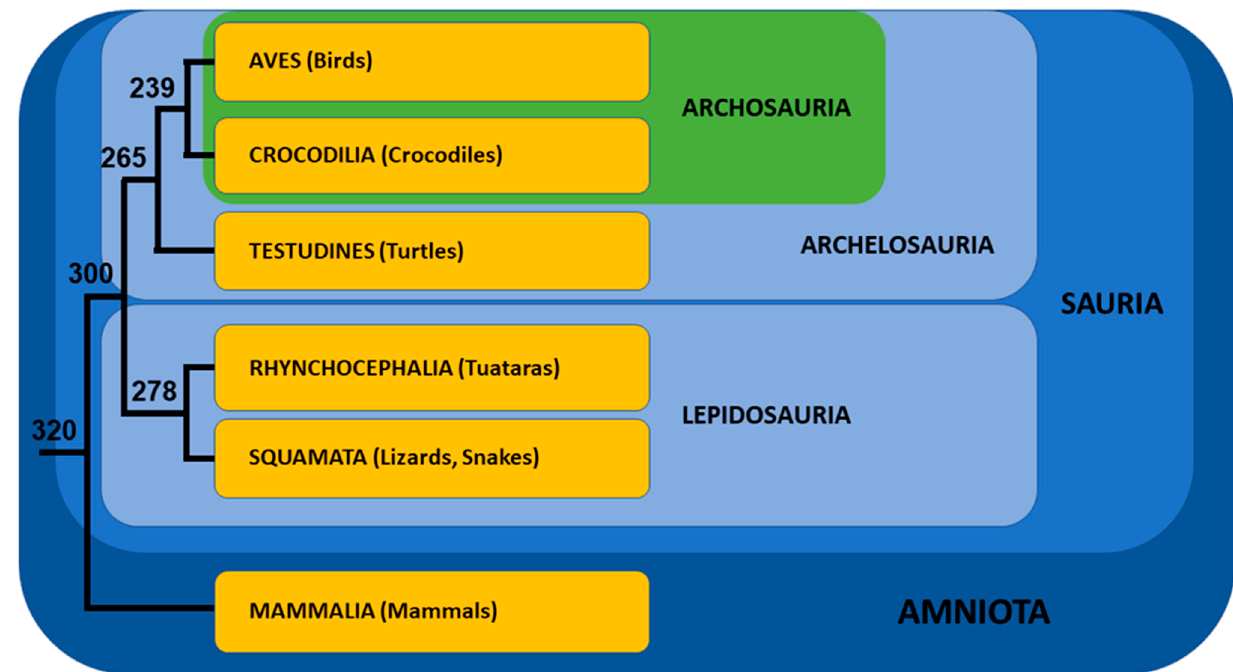
Figure 2. Phylogenic tree of amniotes. Relative position and grouping of each clade are shown. Branch lengths are not proportional to time. Numbers indicate divergence time (Myrs) from present for nodes, according to [38]. Colors indicate the different level of clades in the phylogenetic tree.